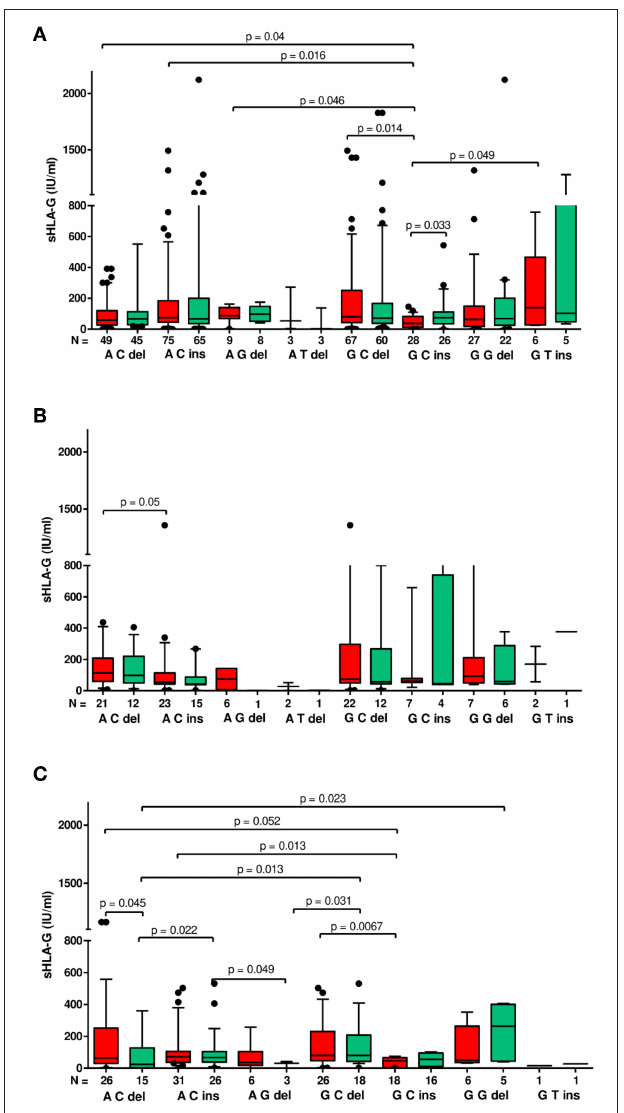
FIGURE 3 | Concentration of soluble HLA-G per ml of plasma (IU/ml) according to HLA-G haplotypes in different clinical outcomes. Haplotypes were estimated in the following order: rs1632947: − 964G > A; rs1233334: − 725G > C/T; rs371194629:insATTTGTTCATGCCT/del. sHLA-G was measured in patients who achieved clinical pregnancy (A) , with lack of pregnancy (B) , and with miscarriage (C) . Boxes are drawn from the first quartile (25th percentile) to the third quartile (75th percentile). Black lines in boxes are medians. Whiskers represent 10–90 percentiles. N is the number of patients. sHLA-G was measured before (red boxes) and after embryo transfer (green boxes). p -values are calculated by Mann–Whitney test.